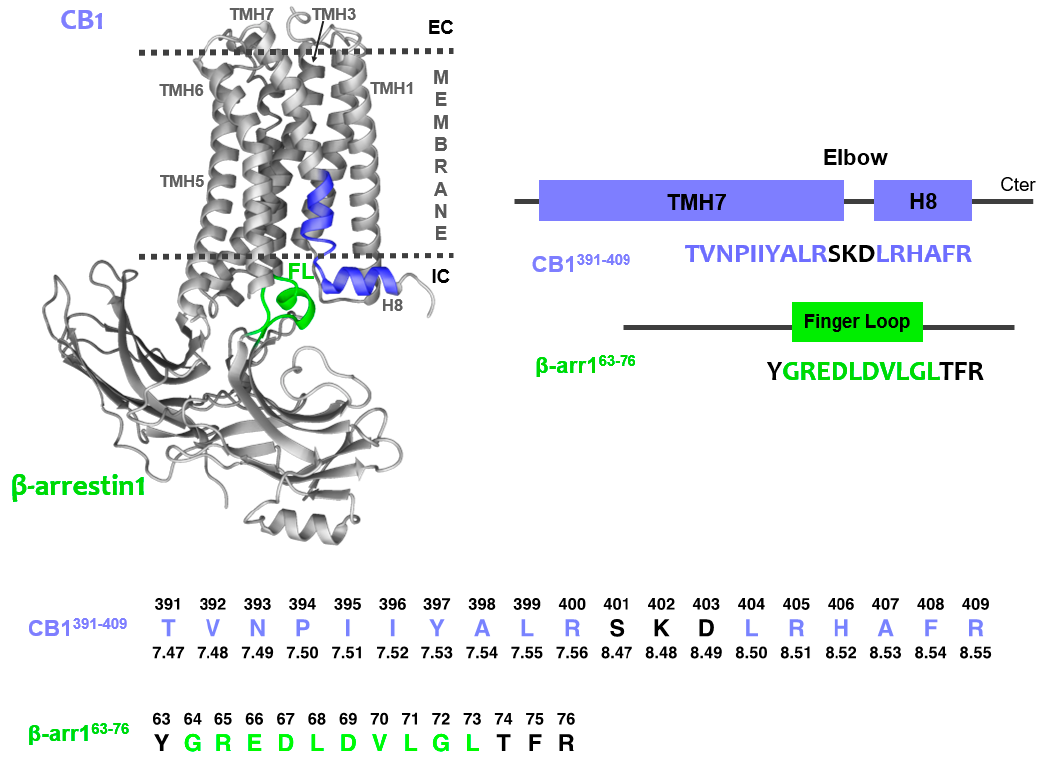
Figure 1. CB1 / β -arrestin1 complex model [templates: PDB 5XRA (CB1 receptor active state crystal structure) and 5W0P (Rho / β -arrestin complex)]. The CB1 / β -arrestin1 interface to be studied is colored (green: β -arr1 63-76 ; blue: CB1 391-409 ) while other domains in the GPCR and the scaffolding protein are represented in grey. Note that β -arrestin finger loop (FL) is not helical in other reported GPCR / β -arrestin complexes [51–53]. At the bottom, the absolute sequence numbers are shown above the peptide sequences; in the case of CB1 391-409 the Ballesteros and Weinstein numbering of GPCRs is indicated below the sequence.